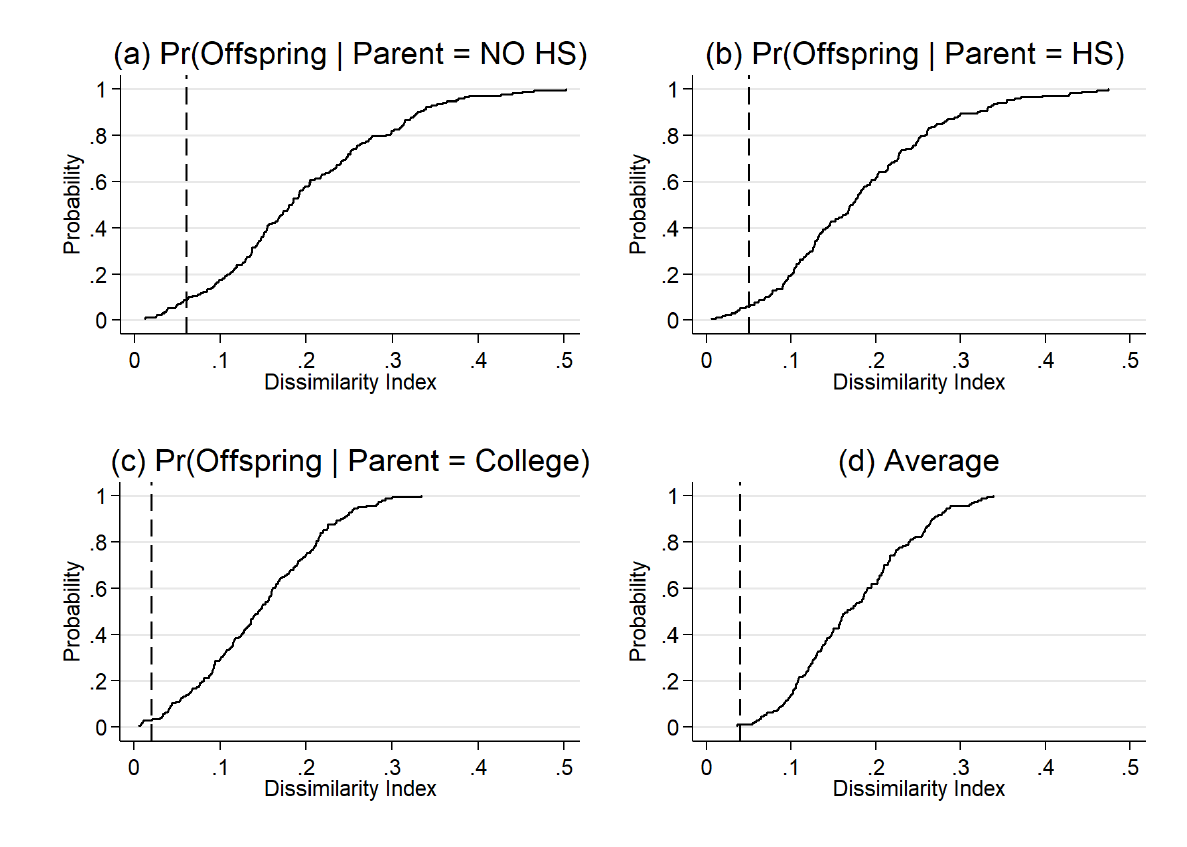
Figure 1: Cumulative distribution functions of Duncan’s dissimilarity index in 171 pairwise country comparisons based on data published in Pfeffer (2007). Note: Estimates based on collapsing the mobility tables published in Pfeffer (2007) to the three-level educational degree classification that A&T use (i.e., ISCED 0/1/2, ISCED 3, and ISCED